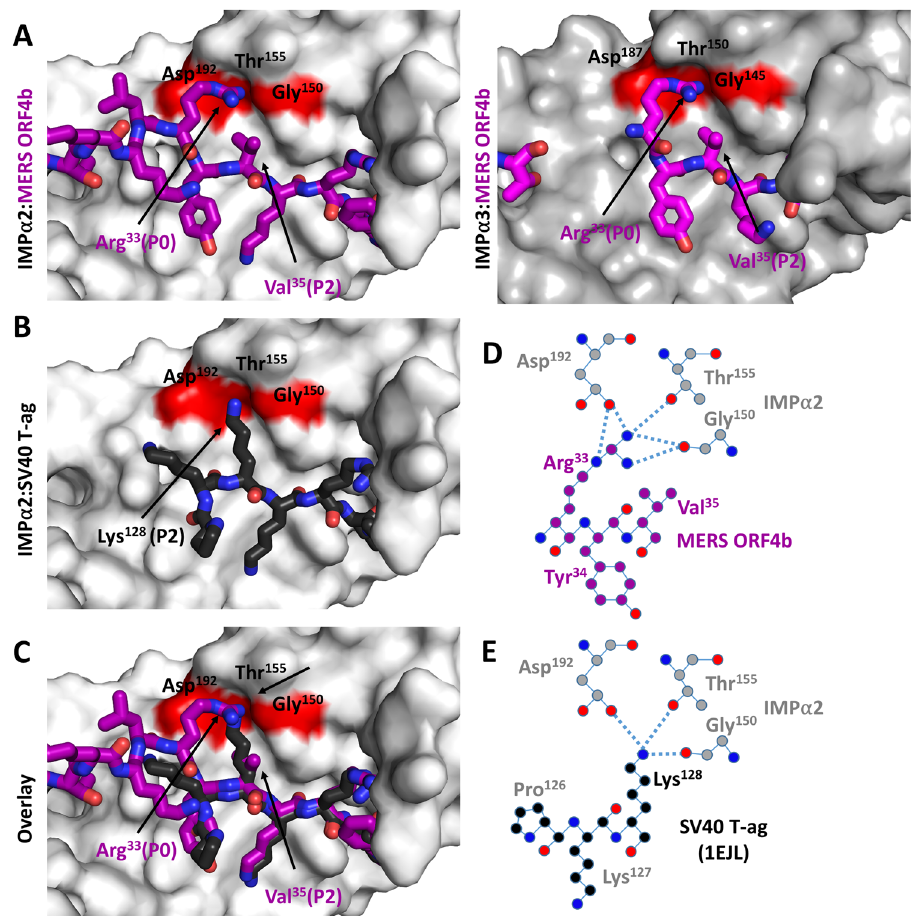
Fig. 2 MERS ORF4b interacts with IMP α 2 via an unusual P0 Arg binding mechanism at the major site. A Detailed view of MERS ORF4b bound at the major site of IMP α 2 (left) and IMP α 3 (right). IMP α 2 and α 3 are colored light and dark gray respectively and shown in surface view, and the MERS ORF4b is colored magenta and shown in stick view. Pymol software was used to generate images 45 . MERS-CoV ORF4b binds IMP α without the use of a Lys at the P2 position, and instead has a Val at this position. This is compensated by an Arg at the P0 position. B Comparison view of the well-characterized SV40 T-ag NLS bound to IMP α 24 , showing a well-characterized Lys at the P2 site. Other viral NLSs using this canonical Lys P2 site are displayed in Supplementary Fig. 2. C Overlay of MERS ORF4b and SV40 T-ag binding at the P2 site on IMP α 2. D Detailed hydrogen bonding mediating the MERS ORF4b Arg 33 P0 at the Gly, Thr, Asp bonding pocket of IMP α 2. Bonds are denoted as dotted lines between atoms, and coloring is preserved within A . E Detailed hydrogen bonding mediating the SV40 T-ag Lys P2 at the Gly, Thr, Asp bonding pocket of IMP α 2. Bonds are denoted as dotted lines between atoms, and coloring is preserved within B . MERS Middle East respiratory syndrome-related coronavirus, IMP α importin alpha, SV40 T-ag Simian virus 40 large T